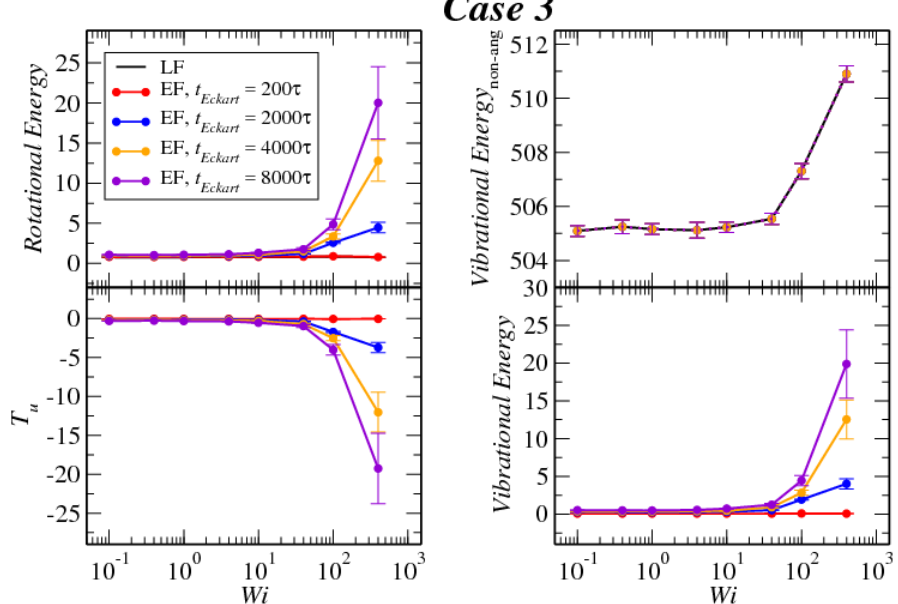
Figure 10. Comparison between the values of the kinetic energy for Case 3 evaluated in both the lab and Eckart frames at different Eckart’s times (Table